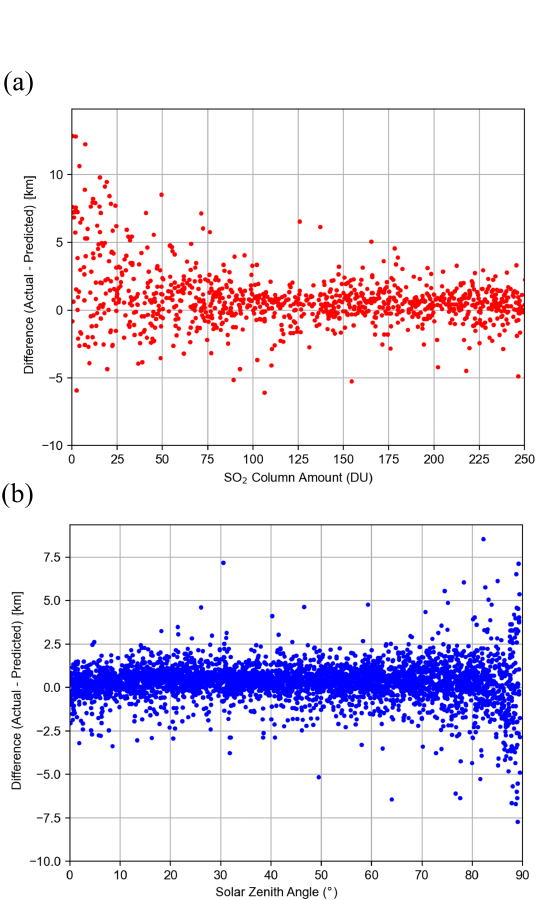
Figure 5. Dependence of retrieval errors on (a) SO 2 amount and (b) SZA for cases with SO 2 VCD > 40DU. The error is defined as the difference between the SO 2 layer height predicted by the neural network using inputs from the independent test set and the actual height from the same samples. The test set comprises 10% of the original spectral dataset withheld from training the neural network. The plots show that the retrieval error is mostly within ± 2 . 5km for SZA < 70, but it increases significantly for large